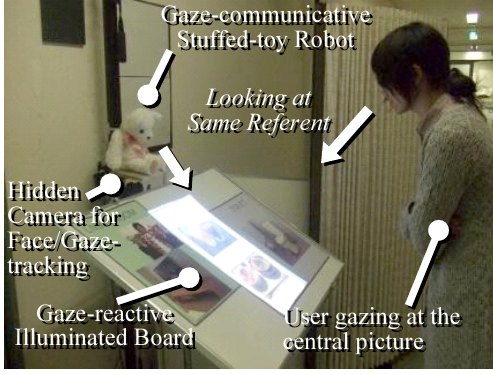
Figure 5. System View of Gaze-communicative Guide